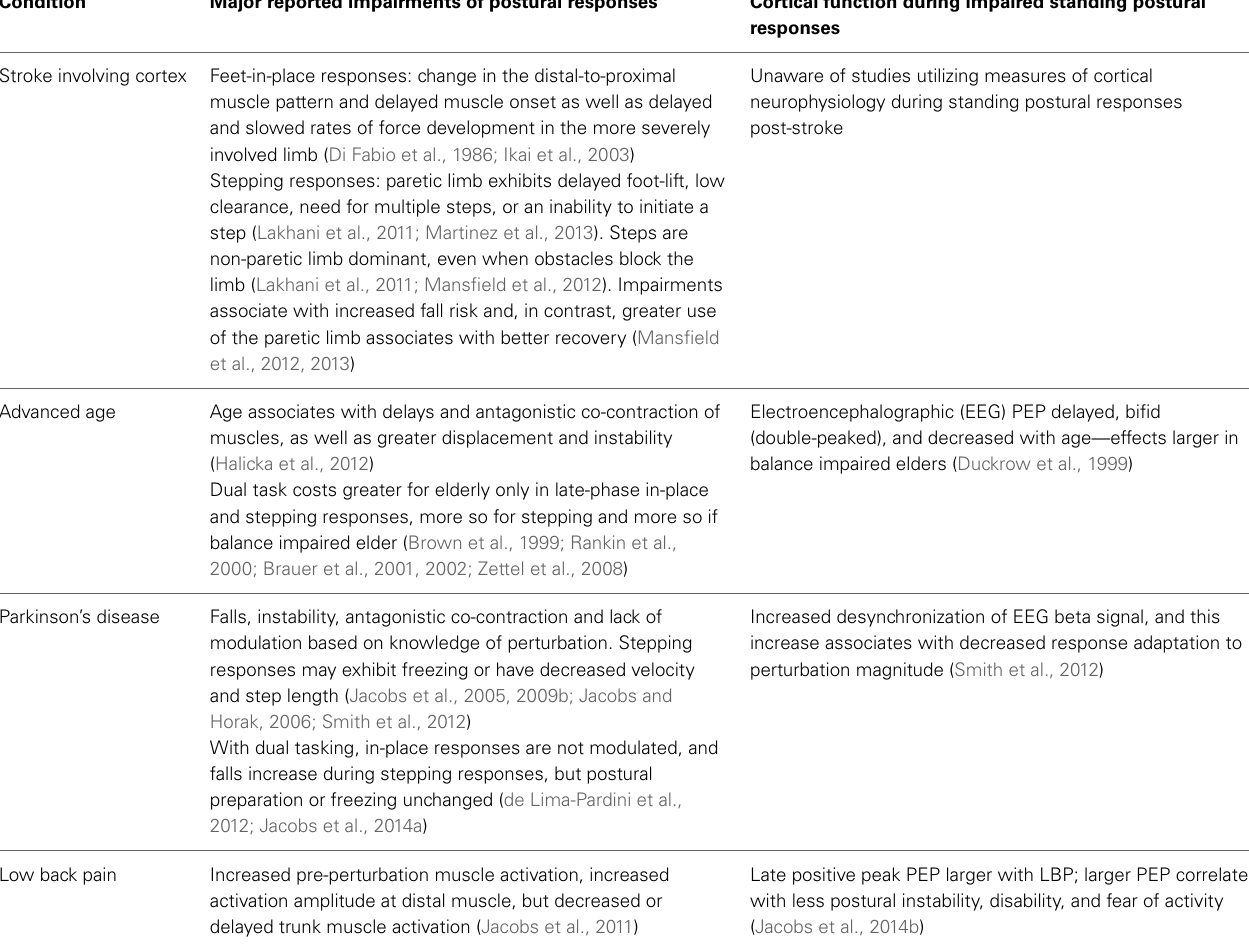
Table 1 | Summarized examples of impaired postural responses and associated cortical function.